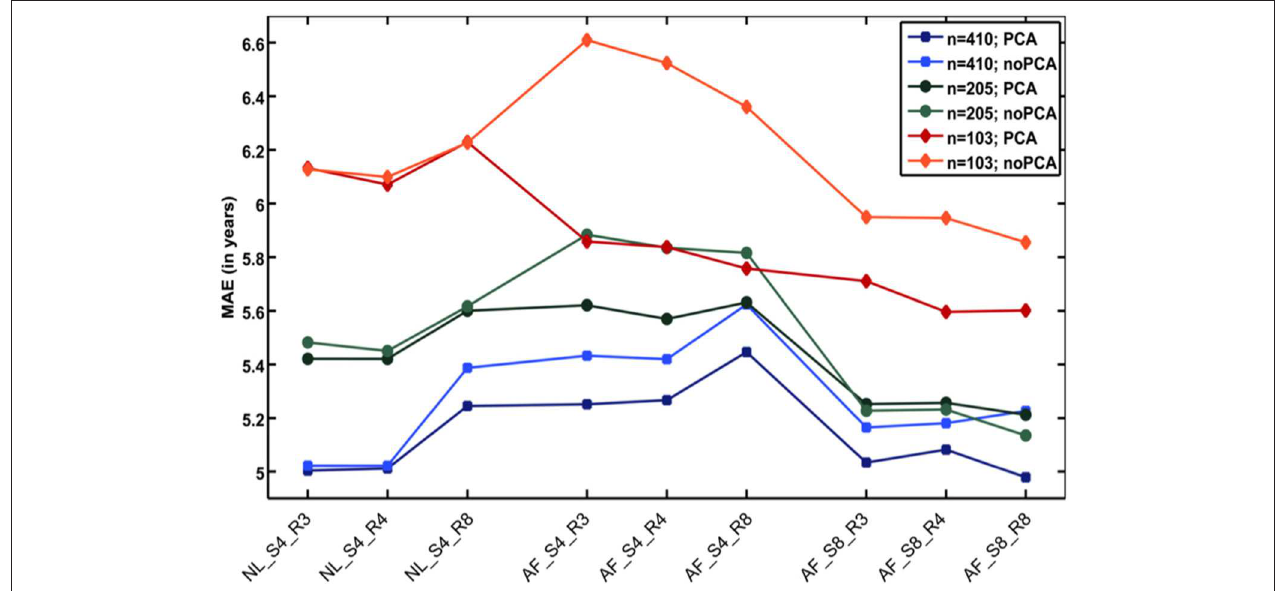
FIGURE 3 | Influences of the various parameters on BrainAGE estimation accuracy. (1) The accuracy of age estimation essentially depends on the number of subjects used for training the age estimation model (blue lines: full training sample; green lines: ½ training sample; red lines: ¼ training sample). (2) The method for preprocessing the T1-weighted MRI images also showed a strong influence on the accuracy of age estimation. (3) Data reduction via principal component analysis (PCA) only had a moderate effect on the mean absolute error (MAE). AF, affine registration; NL, non-linear registration; R4/8, re-sampling to spatial resolution of 4/8mm; S4/8, smoothing with FWHM smoothing kernel of 4/8mm. [Figure and legend modified from Franke et al. ( 32), with permission from Elsevier,